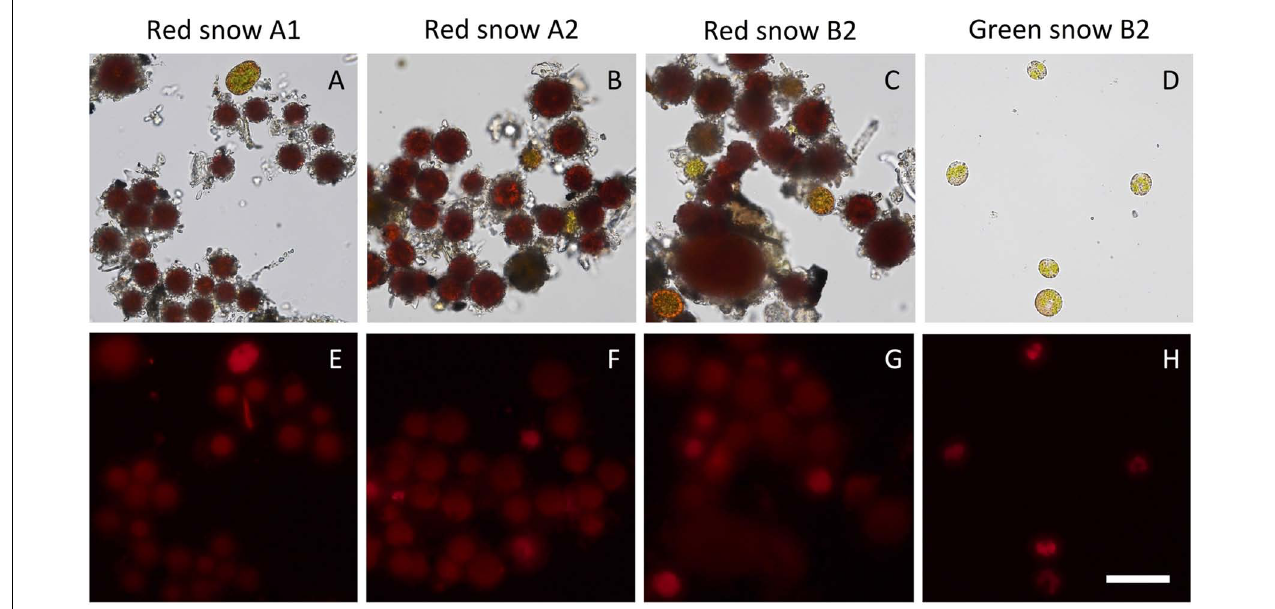
FIGURE 2 | Microscopy images of three red snow samples and one green snow sample from Mt. Asahi. (A–D) Brightfield images, (E–H) chlorophyll autofluorescence. Scale bar represents 50 µ m for all images.